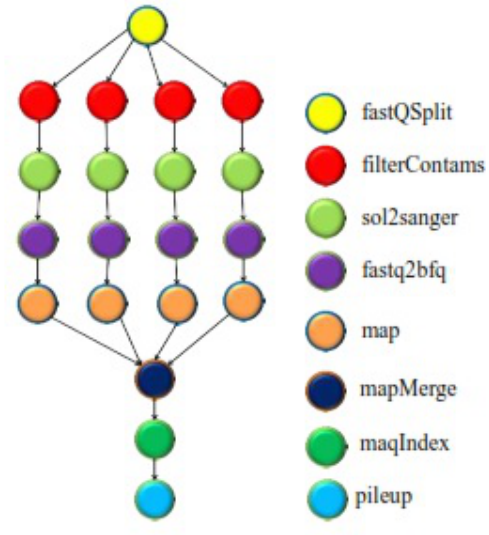
Figure 6. Epigenomics